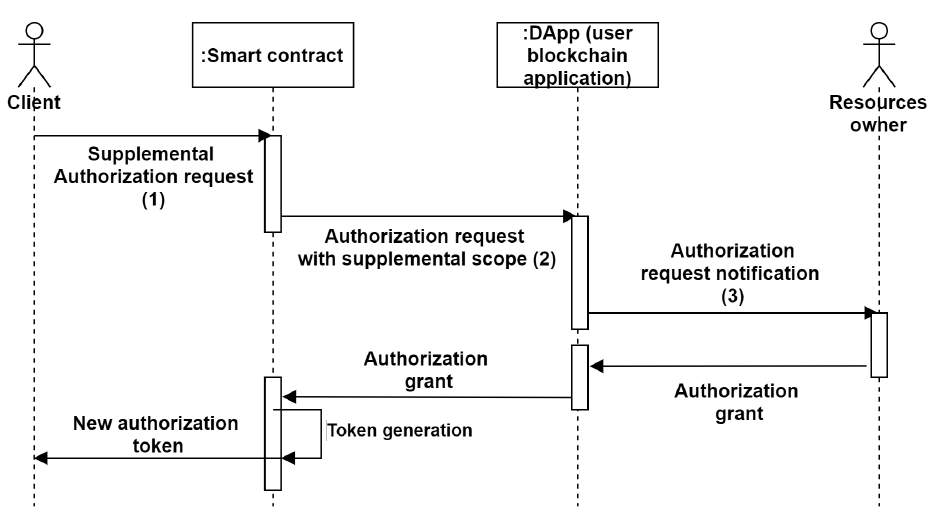
Figure 7. Supplemental authorization request